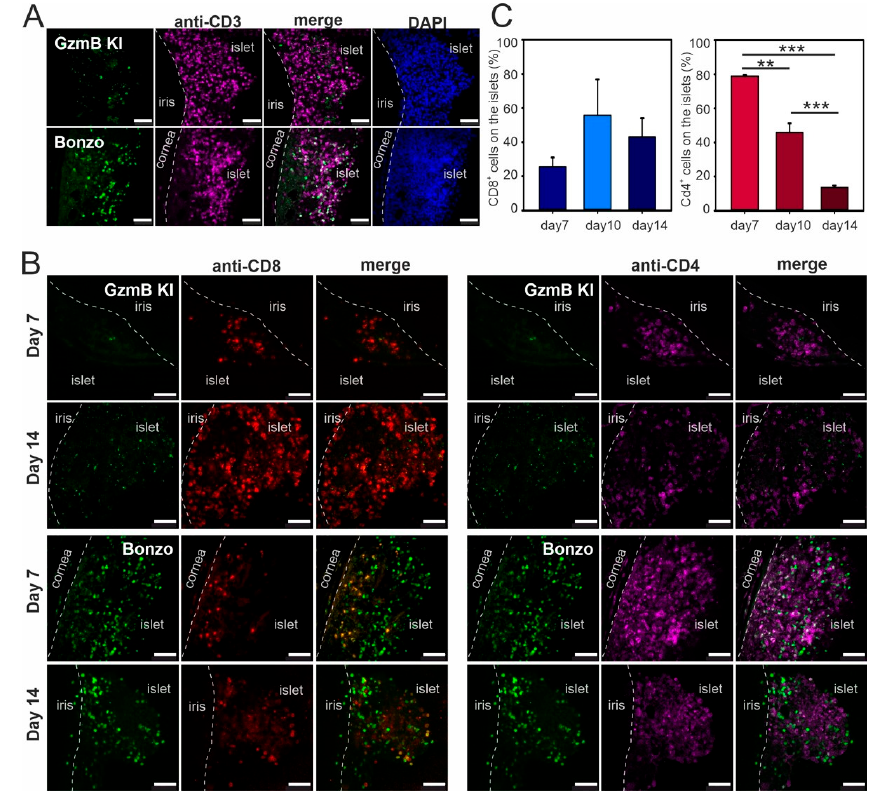
Figure 3. Infiltration kinetics of T lymphocytes into islets of Langerhans during allorejection. ( A ) Confocal images of histological sections of the eye containing pancreatic islets. Infiltrated lymphocytes were